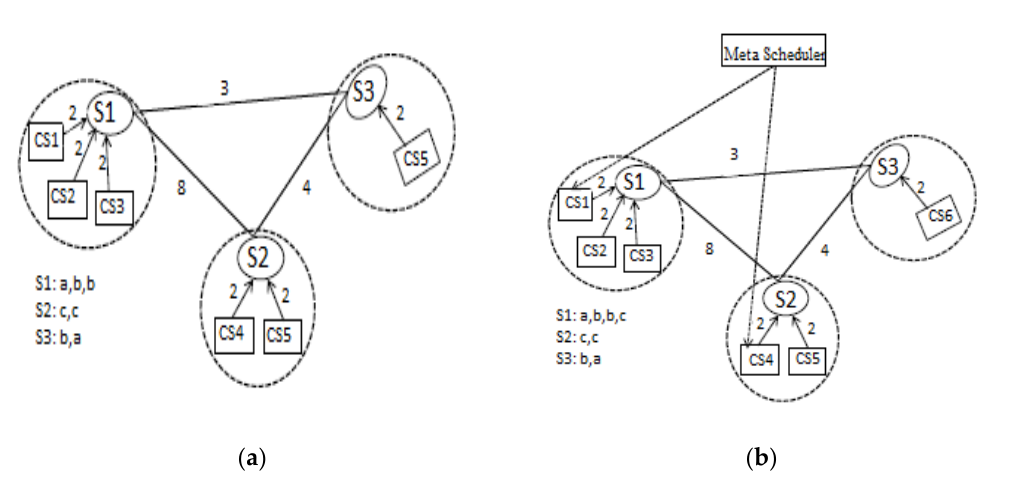
Figure 3. Illustrative example ( a ) without scheduler and ( b ) with scheduler.